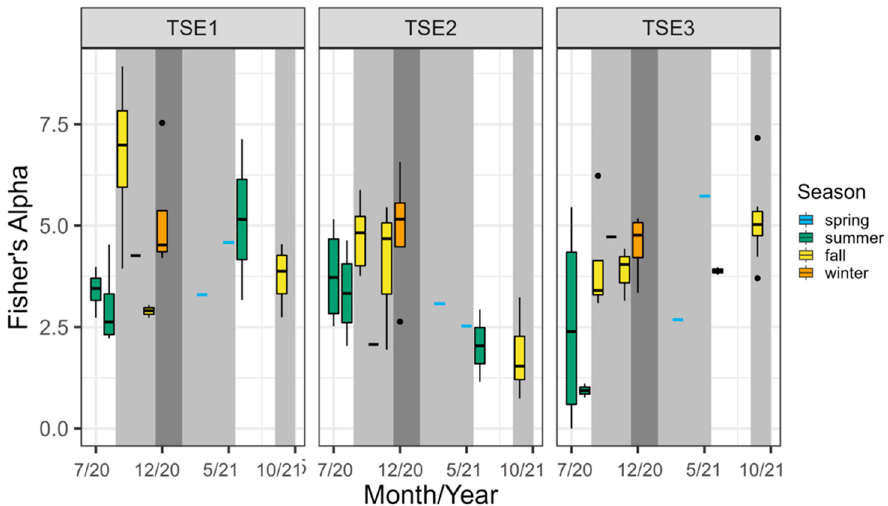
Figure 12. Fisher’s alpha diversity index over time after wetland rehabilitation at each treated sewage effluent pond (TSE) separately. Background shading and boxplot colors indicate stages in the annual cycle (dark grey shading, over ‐ wintering; light grey shading, migration; green boxplots, summer; yellow box plots, fall; orange boxplots, winter; blue boxplots, spring). Boxplots show the median and interquartile range; whiskers include all observations within 1.5 x IQR (interquartile range), and outliers are represented by points. Each TSE pond is in a different panel.